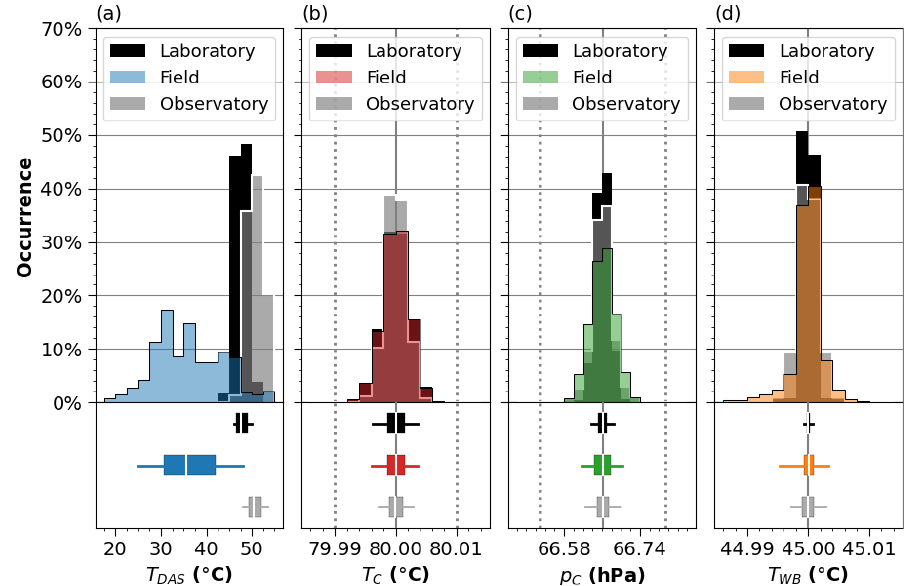
Figure 5. Relative occurrence of (a) DAS temperatures, T DAS (2.5 ◦ C bins); (b) cavity temperatures, T C (0.002 ◦ C bins), (c) cavity pressures, p C (0.02hPa ins); and (d) warm-box temperatures, T WB (0.002 ◦ C bins) during CRDS operation, for field deployment periods (colored) as compared to reference periods, laboratory (black) and observatory (gray). Lower panels show total distributions for the three periods in boxplot form, with the median (white line), interquartile range (IQR; box limits), and 95th and 5th percentiles (whiskers). Solid vertical lines for panels (b) , (c) and (d) indicate parameter target value. Dotted lines for panels (b) and (c) indicate instrument control precision as per manufacturer. Note that “Field” and “Laboratory” overlap closely in panel (b) . Table 2. Analyzer statistics for the overall analyzer temperature ( T DAS ), the cavity temperature and pressure ( T C and p C ), and the warm-box temperature ( T WB ). Percentile intervals as indicated from field, laboratory and observatory periods. Corresponding 95th to 5th span provided for the